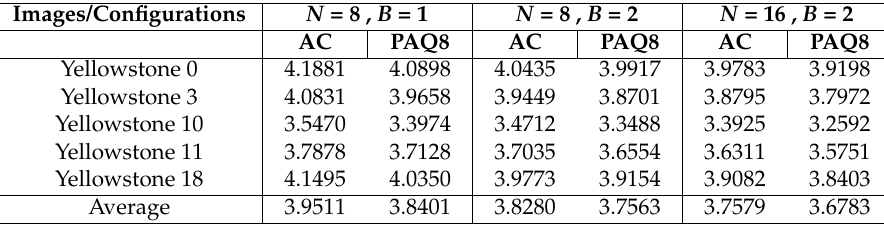
Table 12. Achieved results for the calibrated images of the CCSDS